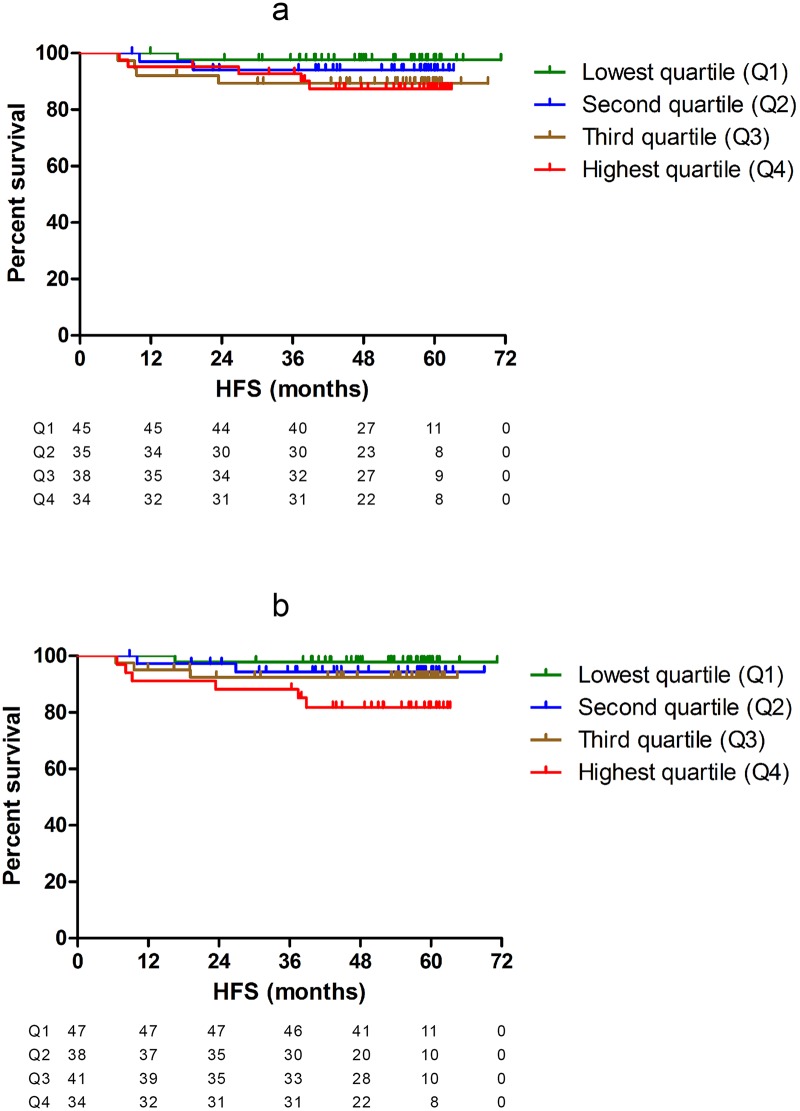
Survival curves for HFS in the LNN subgroup of the MATCH cohort for SYK(T) split in quartiles (a) and for SYK(S) split in quartiles (b).